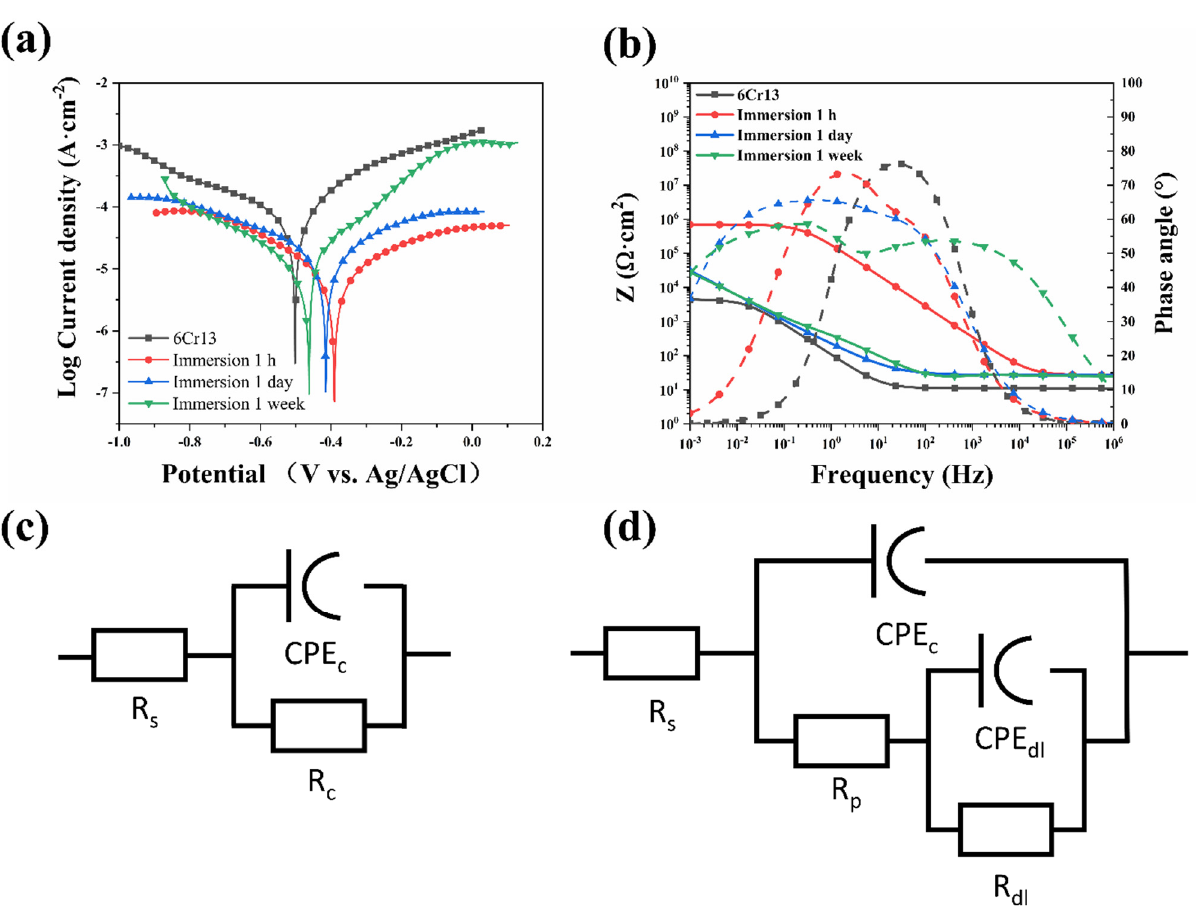
Figure 6. ( a ) Polarization curves of the samples, ( b ) Bode plots of the samples, ( c ) The equivalent circuit used to fit the original sample, and ( d ) The equivalent circuit used to fit the coated sample. Table 2. The corrosion potential ( E corr ) and corrosion current density ( i corr ) of TiB 2 -Chitosan coating.